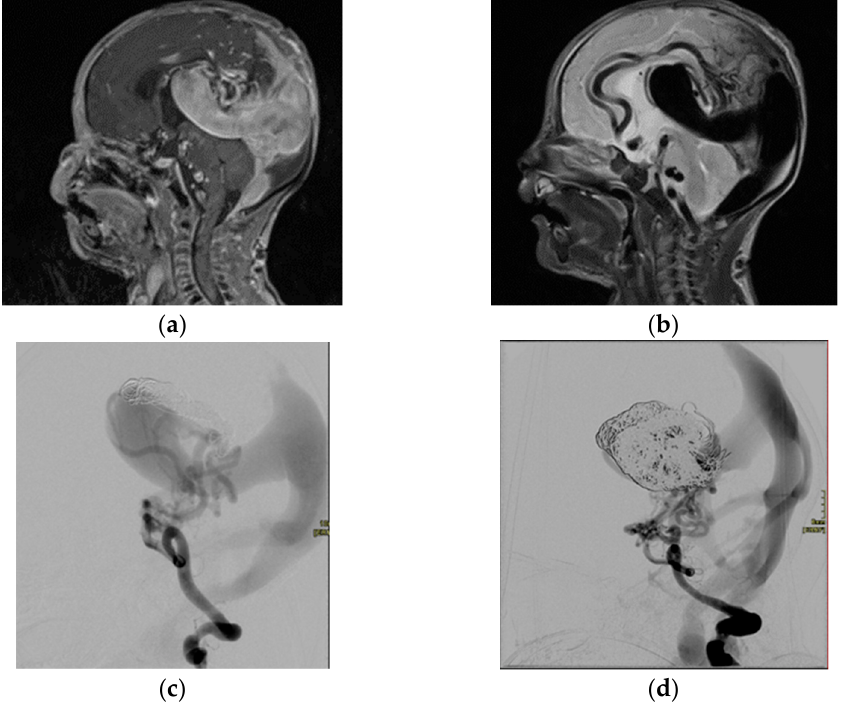
Figure 2. A 2-month-old infant with a choroidal type of Vein of Galen malformation as seen on contrast-enhanced T1 ( a ) and T2 MRI in the sagittal plane ( b ). The malformation has been progres- sively embolized in several staged sessional treatments ( c , d ). Coils have been used for embolization.